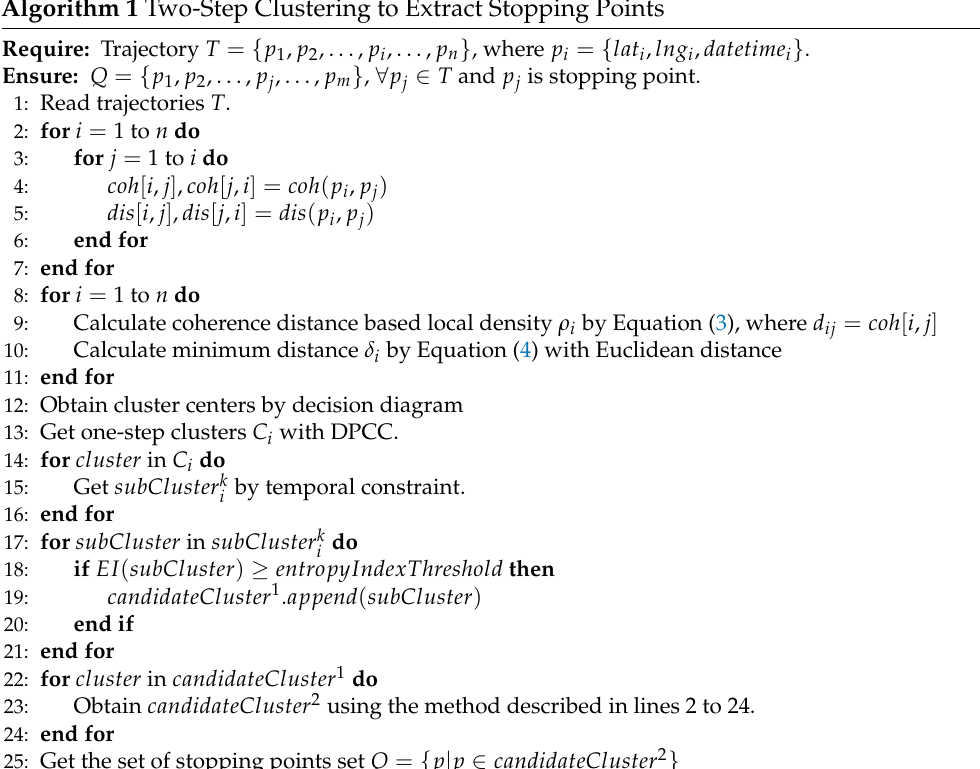
Algorithm 1 Two-Step Clustering to Extract Stopping